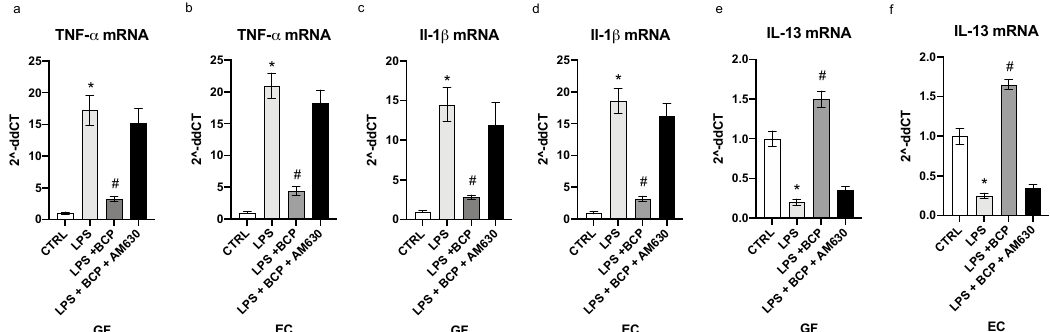
Figure 1. The graphs represent qPCR results of TNF- α ( a ), IL-1 β ( c ), IL-13 ( e ) mRNA expression from GF cells and TNF- α ( b ), IL-1 β ( d ), IL-13 ( f ) mRNA expression from EC cells. Values are expressed as the means and SD. * p < 0.0001 vs. CTRL; # p < 0.0001 vs. LPS.